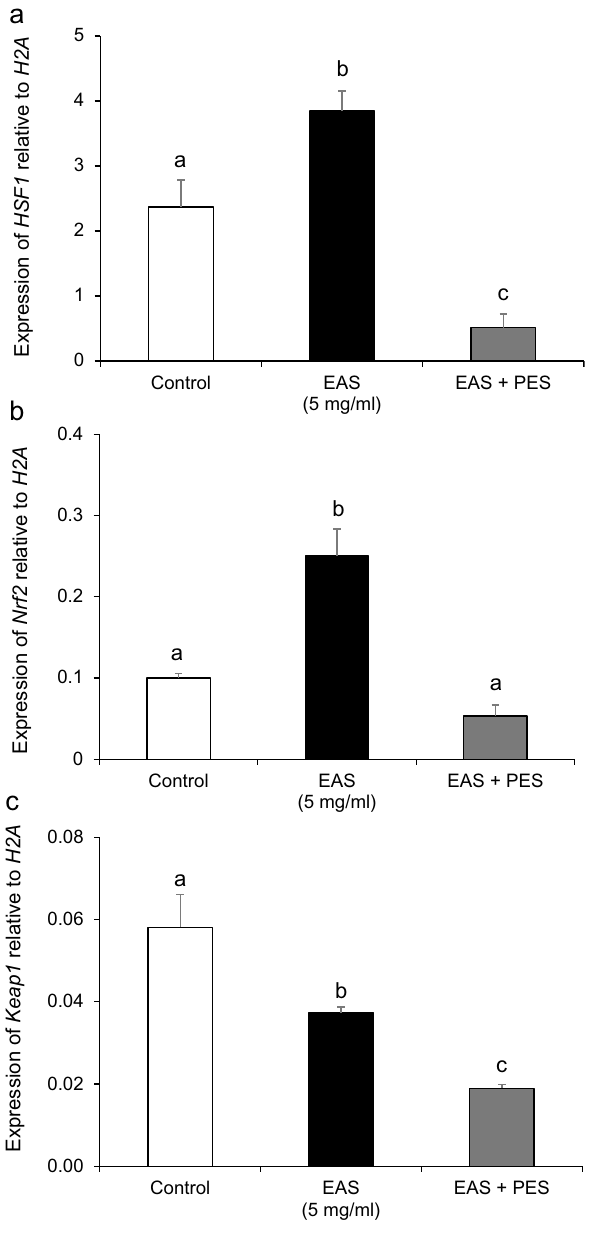
Figure 9. Effect of EAS-induced HSP70 inhibition on expression of HSF1, Nrf2 and Keap1 . Cells were treated for 12 h with or without EAS (5 mg/ml) under normal conditions at 38.5 °C (control, EAS group) and 10 µM PES together with 5 mg/ml EAS (EAS + PES). The expression levels of HSF1, Nrf2 , and Keap1 were examined using real-time quantitative PCR, normalized to H2AFZ as a reference gene. ( a ) HSF1 , ( b ) Nrf2 . Data are shown as the mean ± SEM, n = 5, a vs. b ( P < 0.01), a vs. c ( P < 0.05), and b vs. c ( P < 0.01). ( c ) Keap1. Data are shown as the mean ± SEM, n = 5, a vs. b ( P < 0.05), a vs. c ( P < 0.001), and b vs. c ( P <